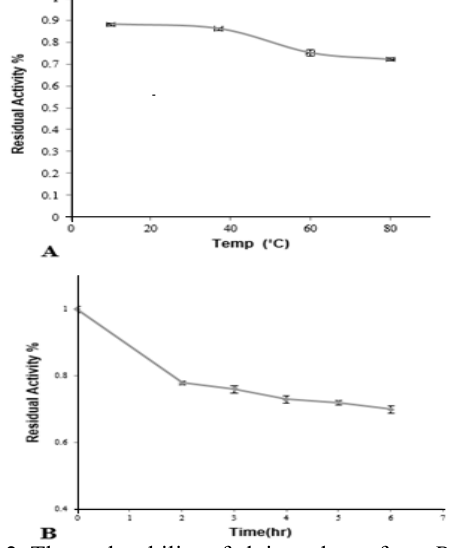
Fig. 2. Thermal stability of alginate lyase from P. aeruginosa strain 293. A) The enzyme was incubated at various temperatures for 1 hr. B) The enzyme was incubated at 80 ˚C up to 6